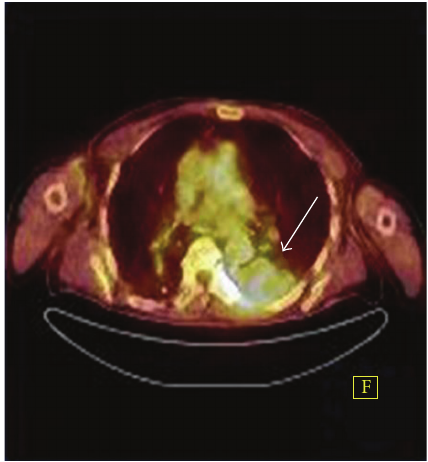
Figure 2: Axial-fused PET/CT image shows a pleural-based tumor with a calculated SUVmax of 4.36 (arrow).